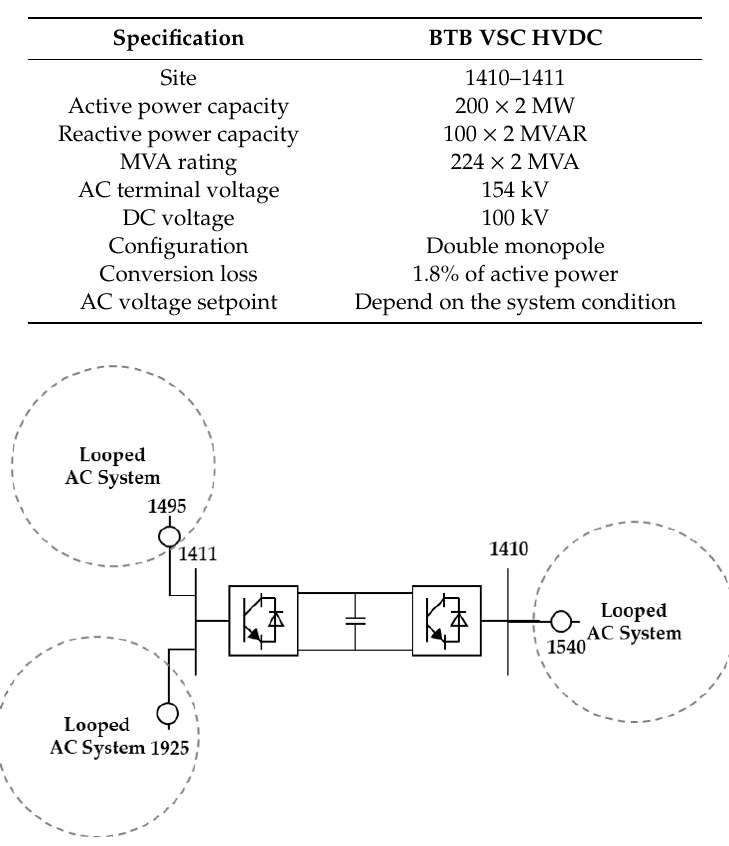
Table 3. Specification of BTB VSC HVDC.